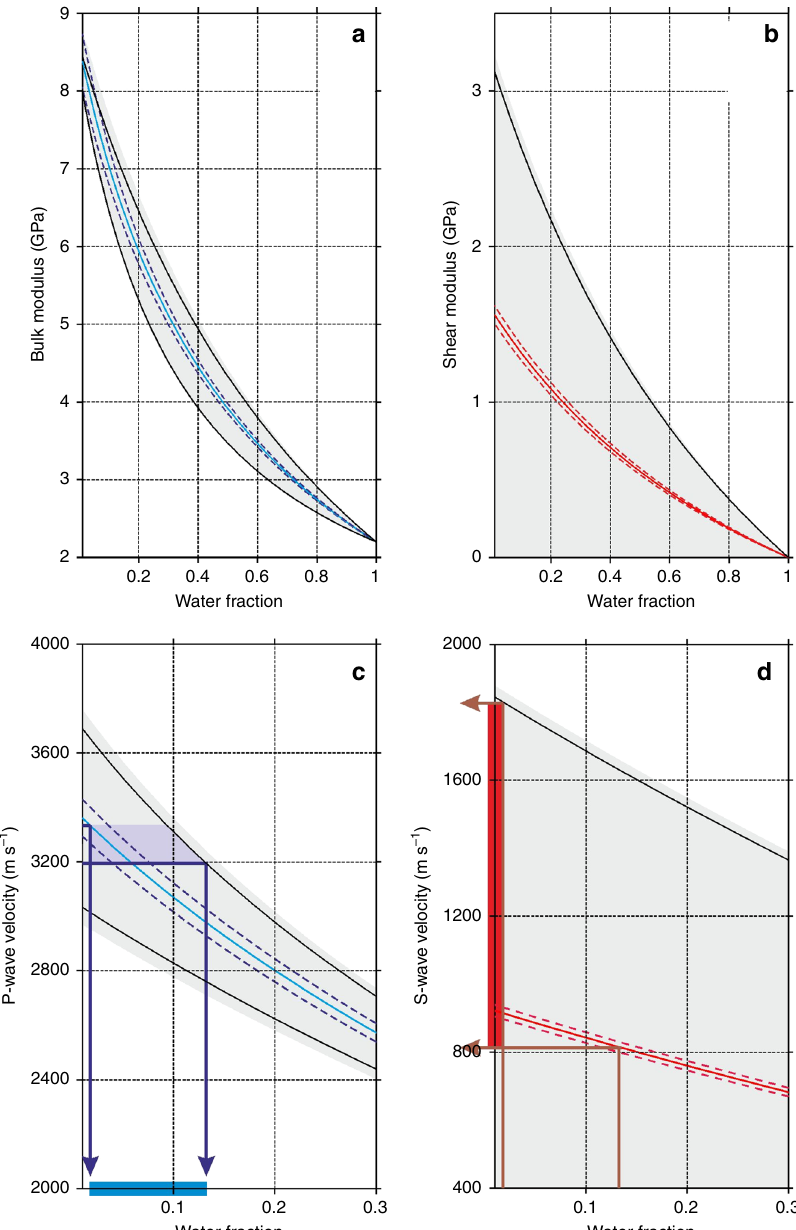
Fig. 8 Elastic parameters of basal marine ice (ISU-5) derived from the Hashin – Shtrikman (H-S) bounds. The analysis assumes the presence of a mixture of ice and seawater of varying fractions. Grey areas show the full range of the H-S bounds in dependence of seawater fraction, for a bulk modulus ( K þ in Eq. (2)); b shear modulus ( μ þ in Eq. (3)); c P-wave velocity; and d S-wave velocity (see ‘ Methods ’ ). Solid blue and red lines show the HS HS Voigt – Reuss – Hill averages, above which the H-S bounds describe a matrix-supported porous solid. In c , the observed P-wave velocity range of basal marine ice (3264 ± 63 m s − 1 ) implies a seawater fraction of ~2 – 13%. In d , this seawater fraction range then implies an S-wave velocity range of basal marine ice of 813 – 1853 m s − 1 . All velocity calculations assume a density of 915 kg m − 3 for meteoric ice and 920 – 990 kg m − 3 for basal marine